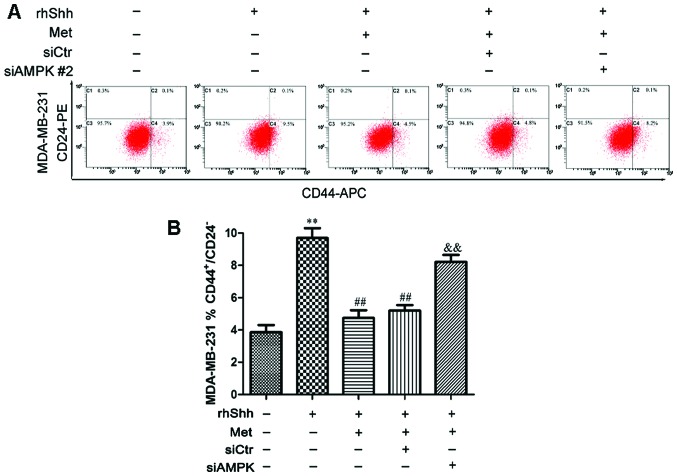
The metformin-induced decrease in the number/percentage of CD44+/CD24− MDA-MB-231 cells is dependent on AMPK. (A) MDA-MB-231 cells were treated with recombinant human Sonic hedgehog (rhShh) or the combination of rhShh and metformin; the cells were treated with sterile PBS as a control and the cells were transfected with siCtr or siAMPK#2 in the presence of rhShh and metformin. The CD44+/CD24− subpopulations were examined by flow cytometry. (B) The histogram illustrates the percentage of CD44+/CD24− subpopulations. Error bars represent the means ± SD; **P<0.01 vs. the Ctr group, ##P<0.01 vs. the rhShh group, &&P<0.01 vs. the cells transfected with siCtr in the presence of rhShh and metformin.